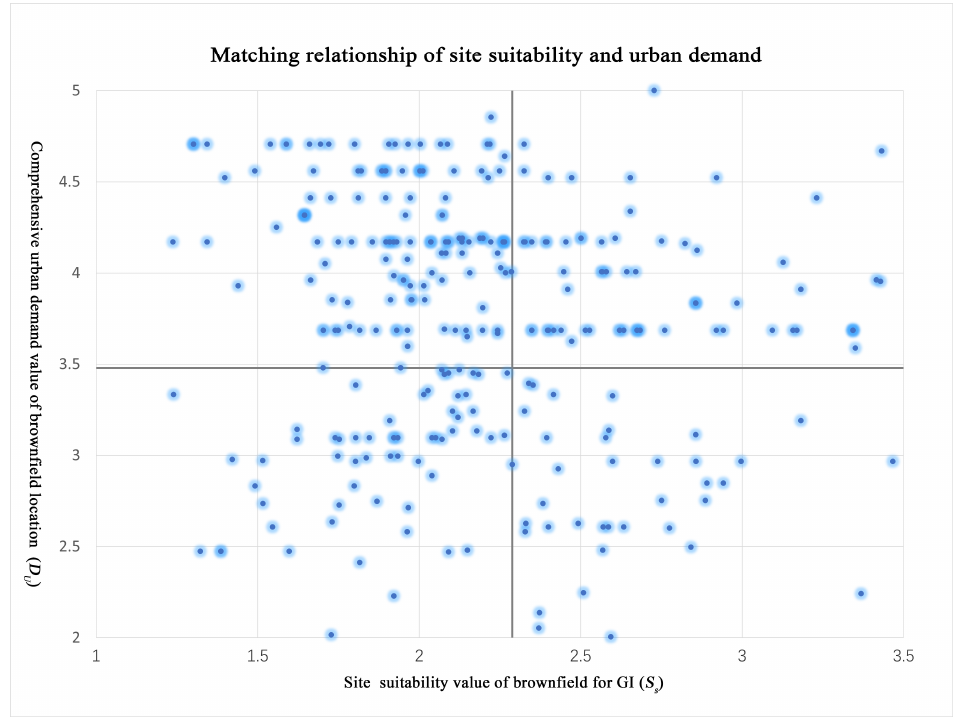
Figure 8. Quadrant division of matching degree between site suitability and urban demand.